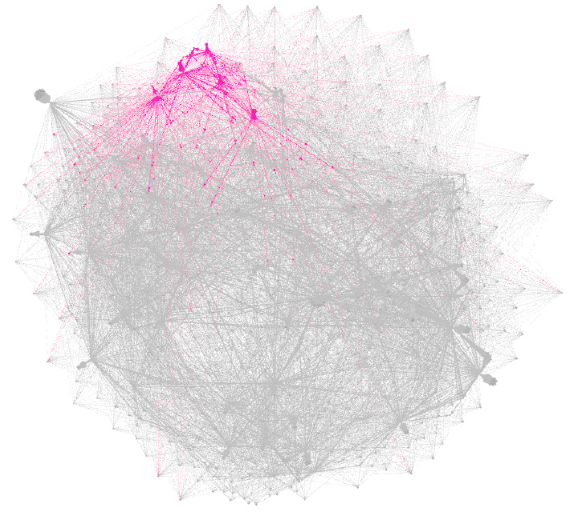
Figure 6. Metabolic-associated network (MAN) of all culturable bacteria from the same with Chromobacterium biofilms. Small molecule metabolites from C. vaccinii are colored in pink, metabolites from other species are colored in grey. Cumulative distance was built via modularity analysis with default thresholds in Gephi after matrix and media signals were subtracted automatically from the network in IDBac.